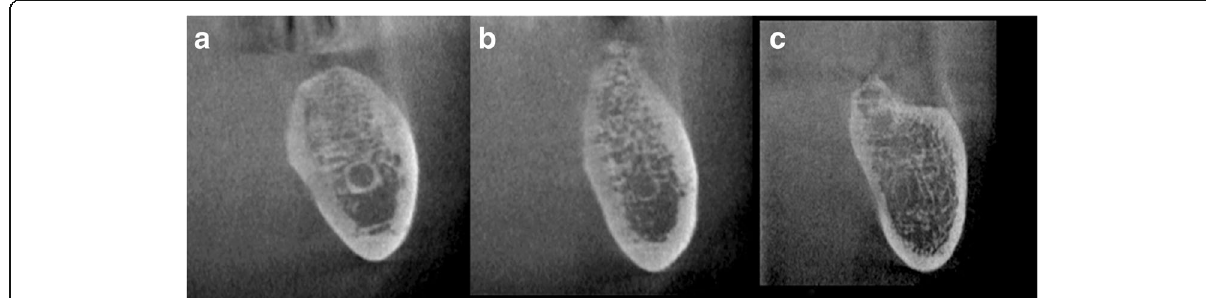
Fig. 2 Visibilities of the superior and inferior walls of the mandibular canal. a Both walls are visible. b Only the inferior wall is visible. c Neither of the walls is visible